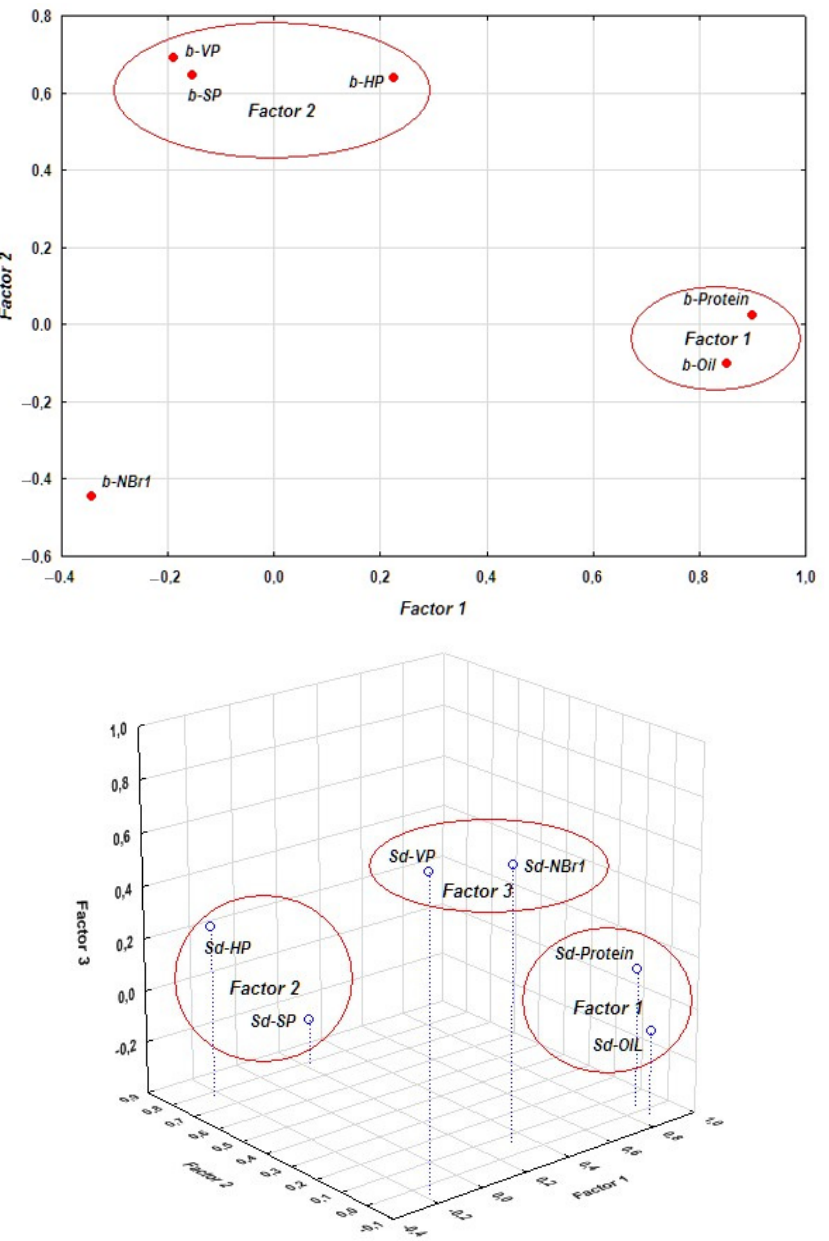
Figure 4. Factor structure of the variation of the studied characters by the stability and plasticity parameters.